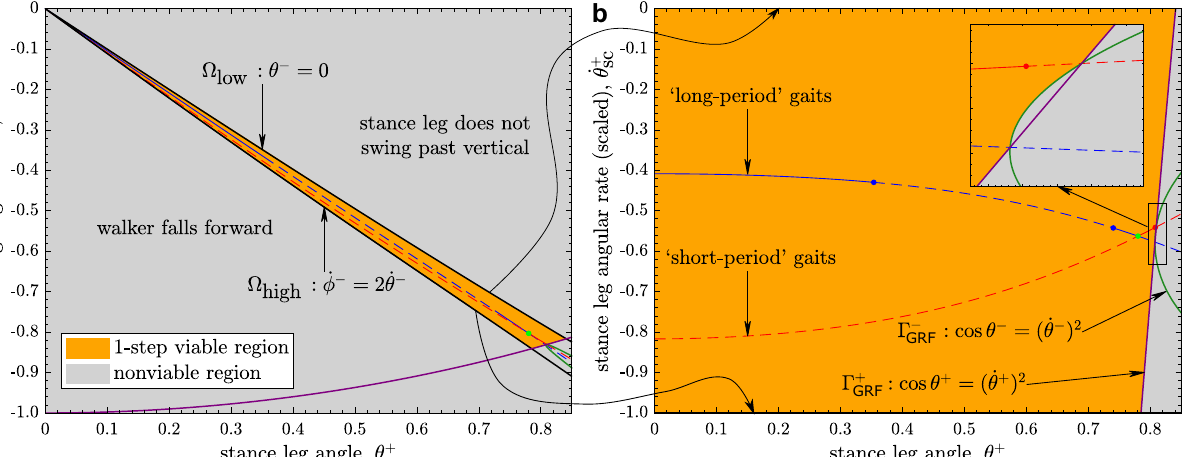
Figure 2. Powered compass walker’s 1‑step viable region V 1 , i.e., the set of states beginning in which the walker takes at least one step while remaining viable, bounded by the curves (cid:31) low , (cid:31) high , Ŵ + GRF , and Ŵ − GRF : ( a ) In the wedge-shaped region in the middle (“1-step” region 19 ), demarcated by the curves (cid:31) low and (cid:31) high , the walker has at least one heel strike though it may not necessarily maintain a nonnegative GRF at the stance foot. Indeed, in the nonviable region , the stance leg either moves too slowly to swing past the vertical, moves too fast so that the walker falls forward, or fails to maintain ground contact throughout the stance phase. Thus, V 1 is a strict subset of the “1-step” region 19 . ( b ) To better visualize V 1 , we plot the state space with ˙ θ + scaled to ˙ θ + − � + ) ˙ θ + θ + ∈ ( 0, 0.85 ] , so that the new variable ˙ θ + (cid:31) low curve low (θ sc (cid:31) sc is 0 on the upper � low (θ + ) − � high (θ + ) for any given and takes a value − 1 on the lower (cid:31) high curve 19 ( freehand arrows ). The period-1 gaits of the walker, viz., “long-period” and “short-period” gaits that repeat every step, along with their open-loop stability, are as in our previous work 19 : solid lines show open-loop-stable gaits, while broken lines depict open-loop-unstable gaits. Inset shows zoomed-in area where Ŵ + GRF , and Ŵ − GRF intersect each other and the period-1